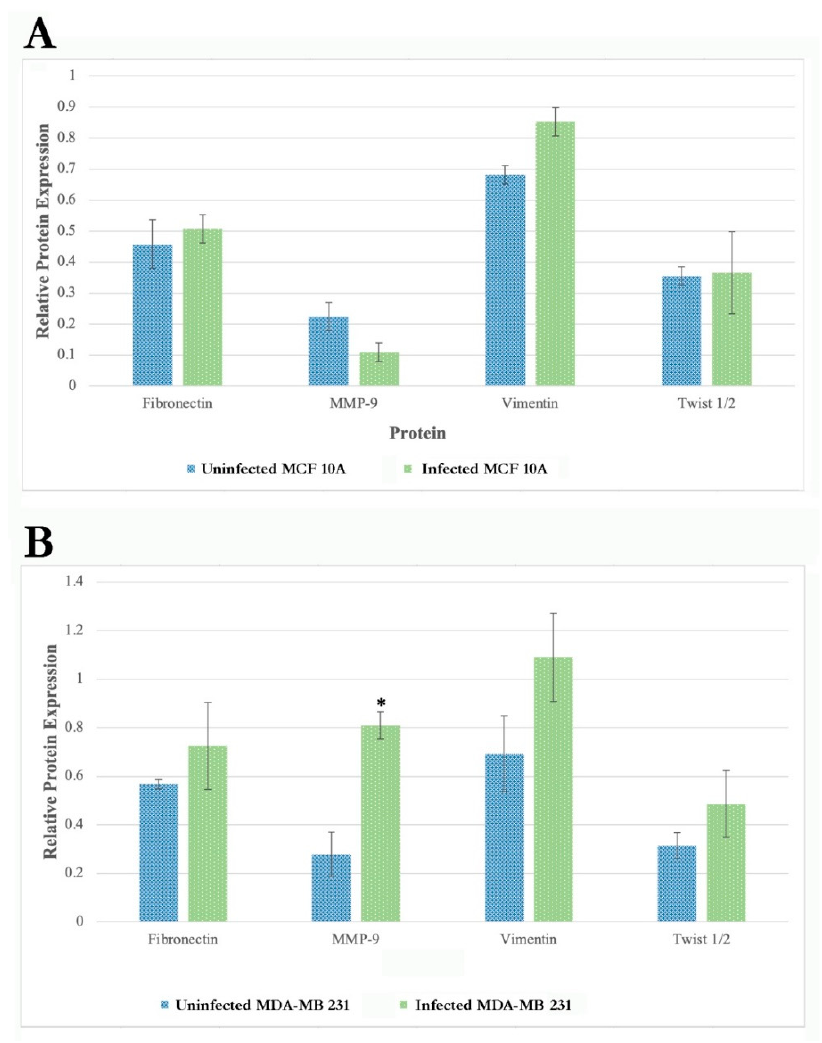
Figure 9. Quantification and statistical analyses of three independent Western blot experiments for the expression levels of Fibronectin, Activated MMP-9, Vimentin, and Twist1/2, as described in Materials and Methods, in uninfected and 72 h infected MCF 10A (Panel A ) and MDA-MB-231 cells (Panel B ). Expression levels of the target proteins were normalized for the loading control GAPDH housekeeping protein. Statistical analyses were performed to find significant differences in protein expression level in infected cells compared to uninfected cells as described in Material and Methods. The error bars represent standard error of mean (SEM). The p -value of the data < 0.05 is considered significant and is indicated by *.